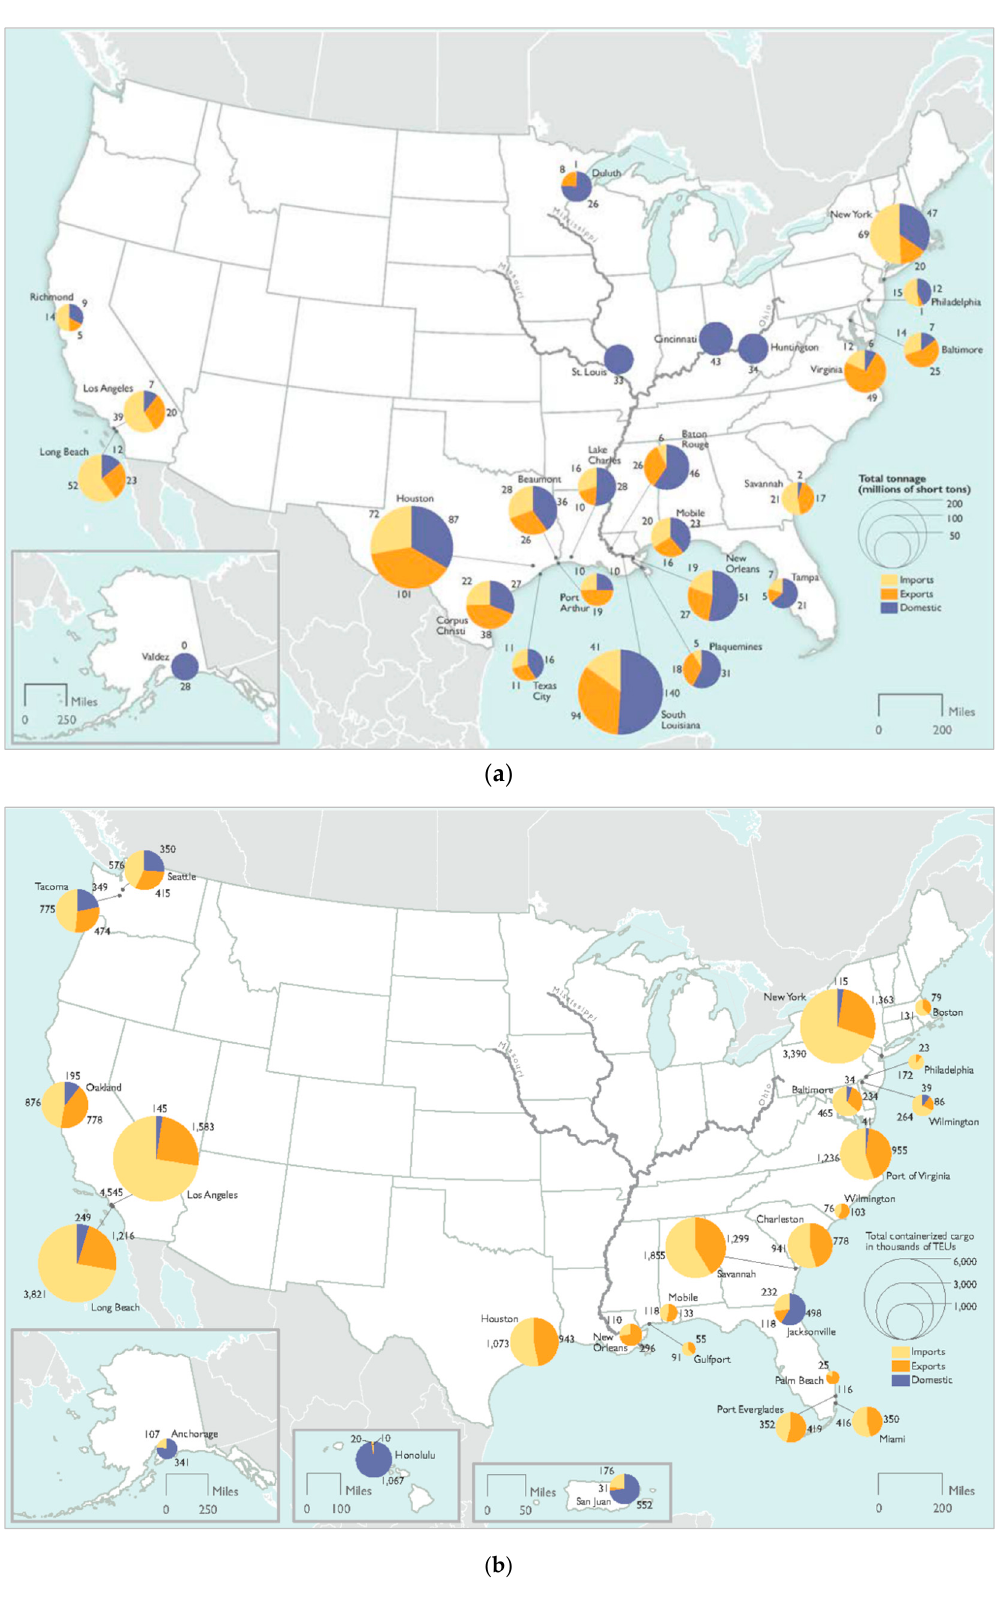
Figure 5. Top 25 U.S. Ports by ( a ) total weight and ( b ) twenty-foot equivalent units (TEU).